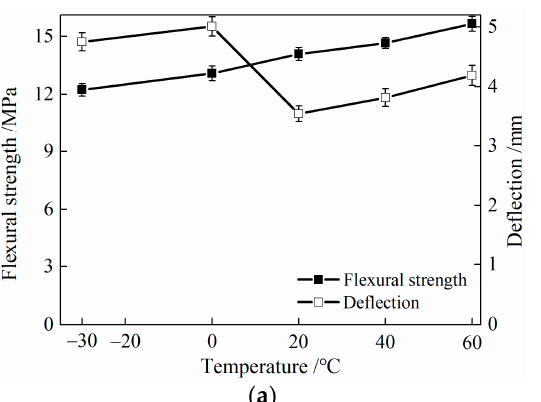
Figure 16. Flexural stress and de fl ection relationship curve of HDC.